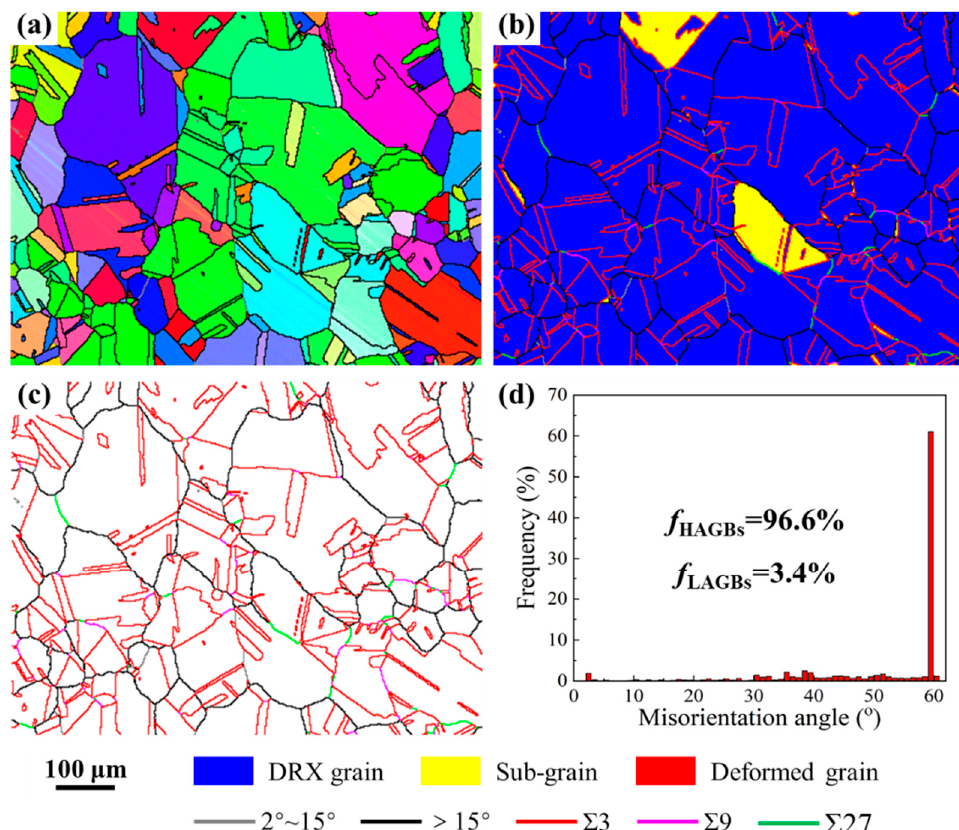
Figure 2. Initial microstructures of the as-received Ni80A superalloy. ( a ) IPF map; ( b ) EBSD maps highlighting DRX volume fraction and grain boundary network; ( c ) band contrast maps with Σ 3 n twin boundaries; ( d ) distribution of misorientation angle.